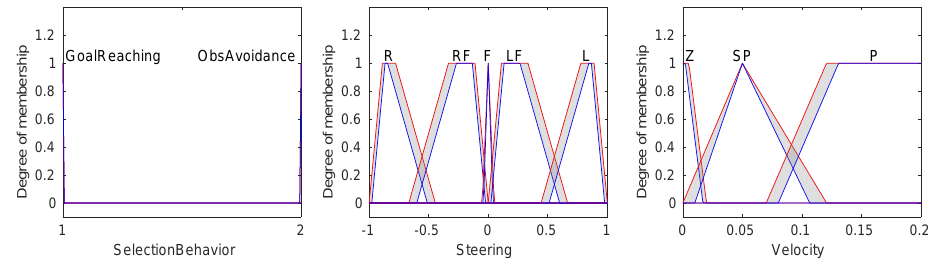
Figure 6. Type-2 Fuzzy Sets in the